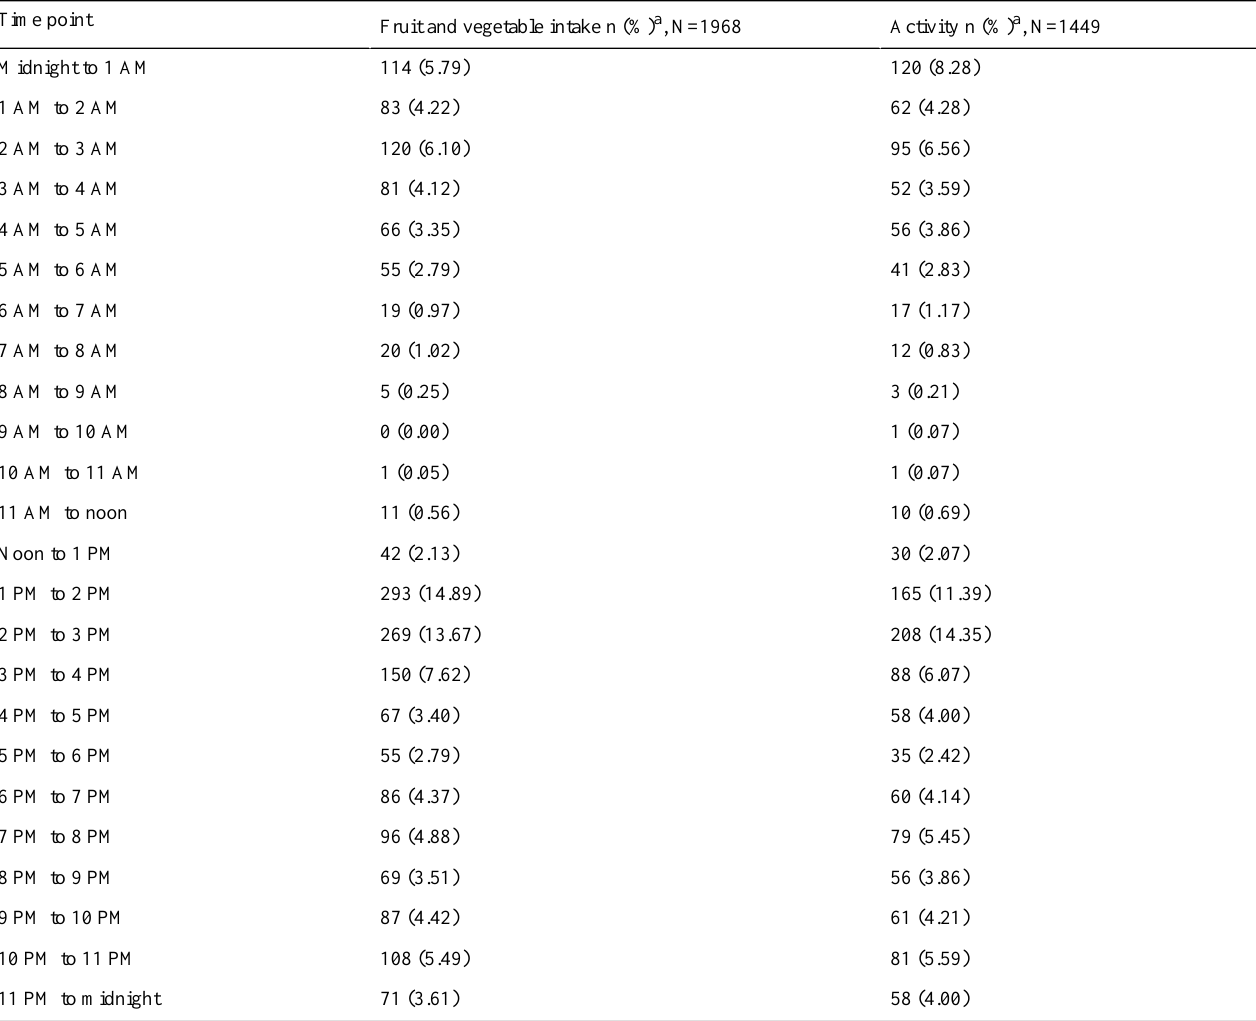
Table 4. Time of day data were recorded.